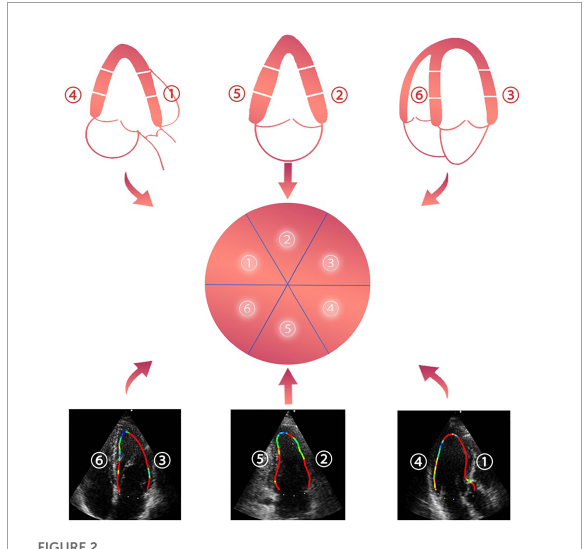
FIGURE2 (cid:192) anteroseptal view, (cid:193) anterior view, (cid:194) anterolateral view, (cid:195) inferolateral view, (cid:196) inferior view, and (cid:197) inferoseptal